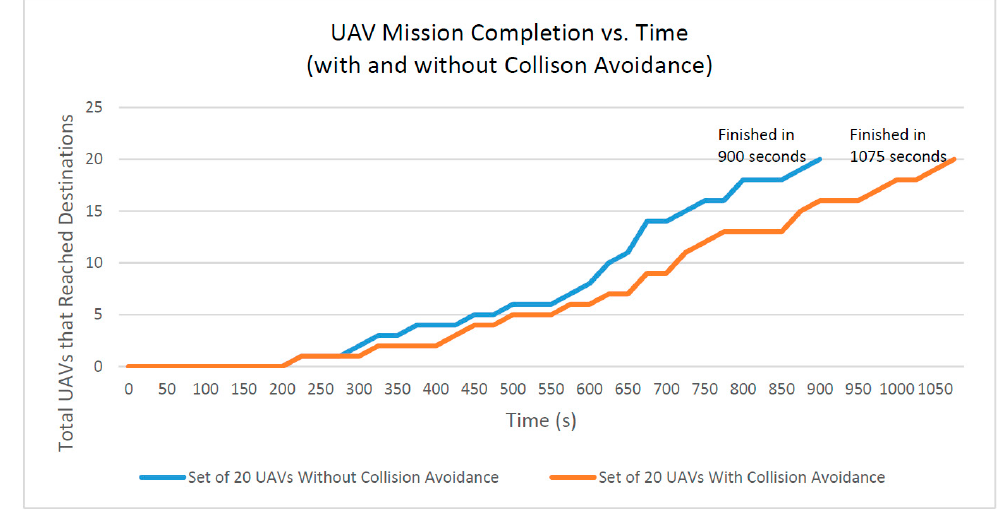
Figure 15. UAV mission completion time.